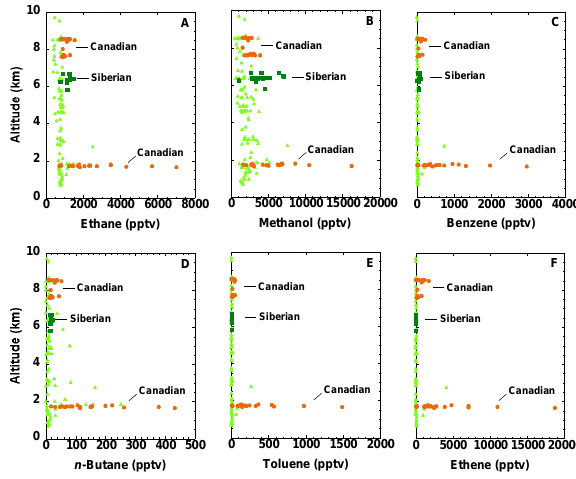
Figure 14. Altitude profiles (lifetimes) of (a) ethane (47 d); (b) methanol (12 d); (c) benzene (9.5 d); (d) n -butane (4.9 d); (e) toluene (2.1 d); and (f) ethene (1.4 d) during Flight 17, showing encounters with Canadian (orange circles) and Siberian (dark green squares) smoke plumes.